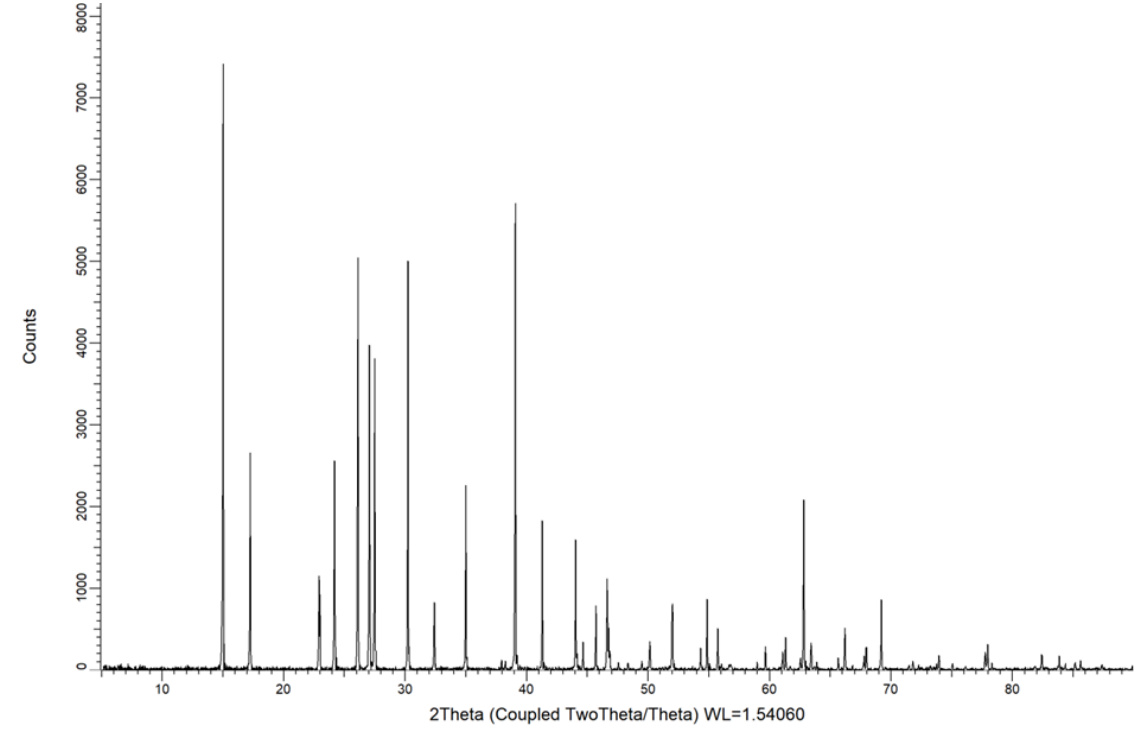
Figure 15. The XRD pattern of AlCl 3 powder.